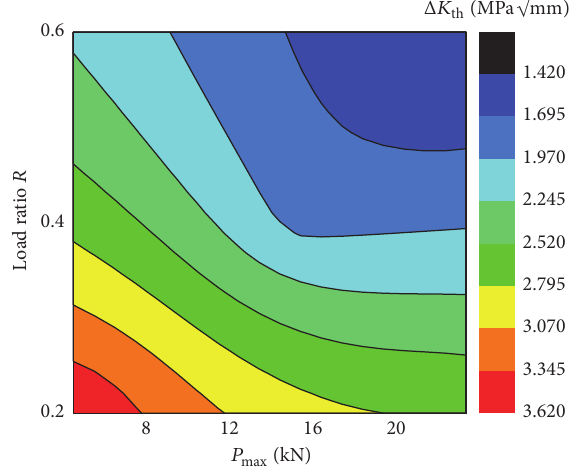
Figure 9: Contour plot of Δ𝐾 th in function of the maximum applied load and the load ratio.